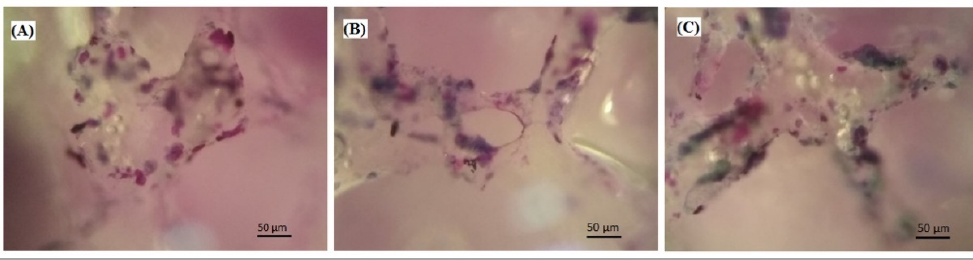
Figure 8. MMSC seeded on PLA ( A ), PLA/HA 15% ( B ), and PLA/HA 20% ( C ) scaffolds at 48 h of cultivation determined with light microscopy. Hematoxylin and eosin staining. cultivation determined with light microscopy. Hematoxylin and eosin